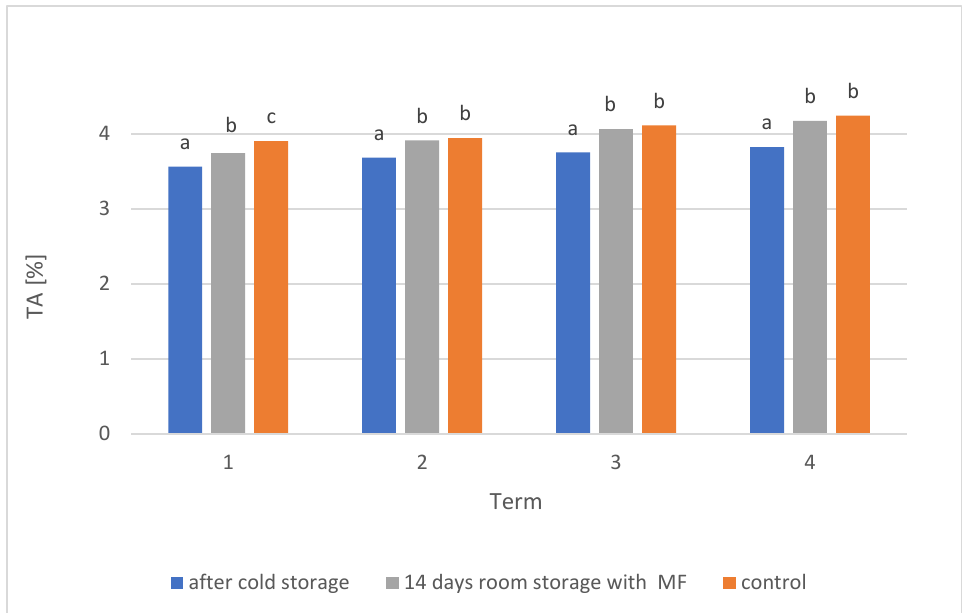
Figure 7. Effects of MF on the TA of Idared apples after 120 days of cold storage. For each experiment, apples were stored in room conditions for 14 days. Statistically significant differences are marked by different letters. Differences between average values that are marked with the same letters (a – b) are not statistically significant. The data were analysed separately for each experiment .